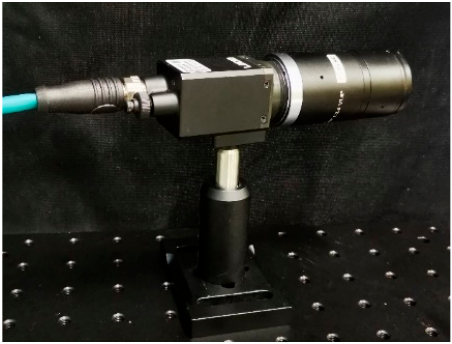
Figure 3. Physical figure of focusing plane polarized camera.